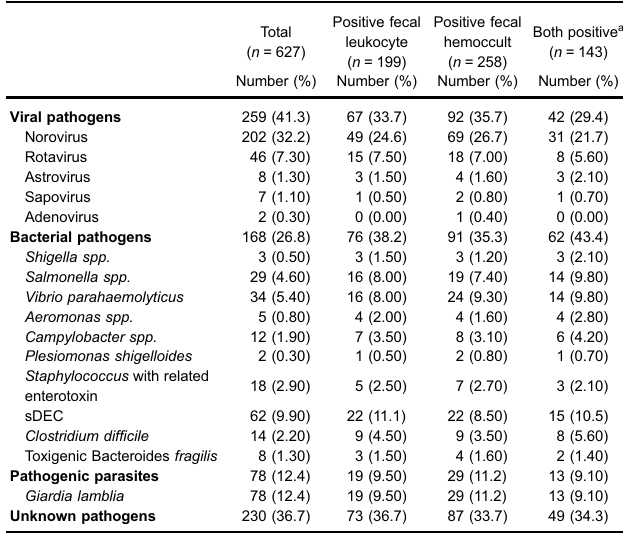
Table 2. Microbiologic fi ndings among